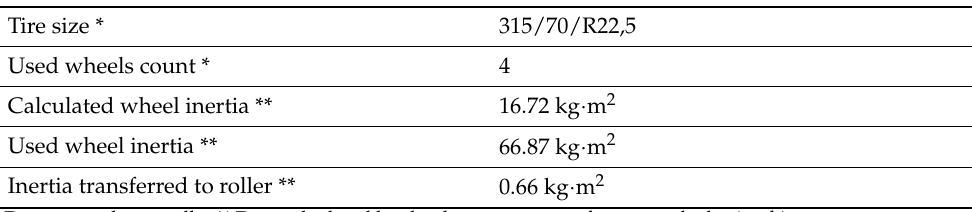
Table 5. Data table for calculating the inertia of the vehicle propulsion system tested on the dy- namometer (authors’